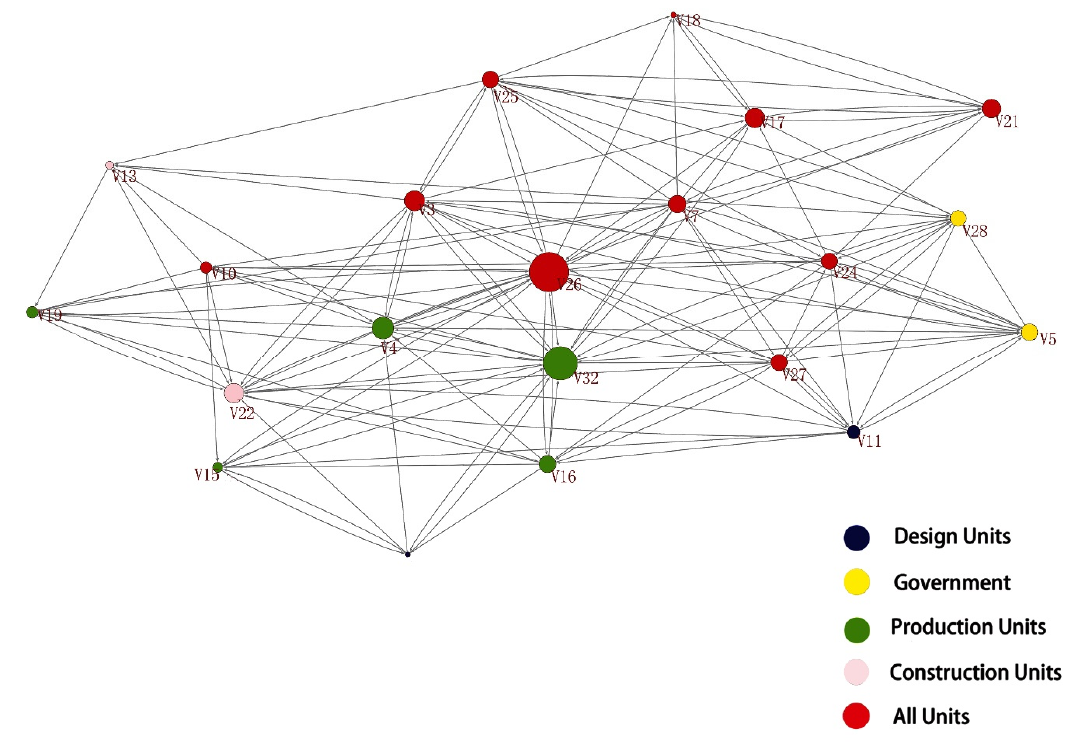
Figure 9. Betweenness centrality visualization of the network.